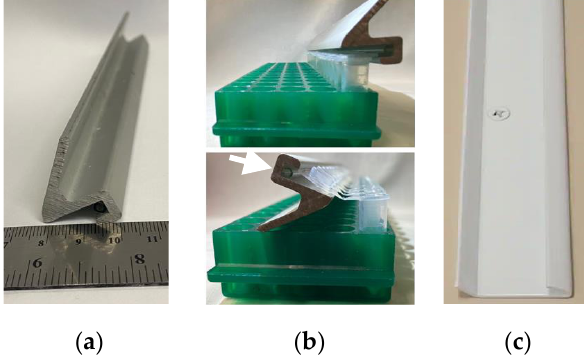
Figure 4. Example of a multi-microtube opener. ( a ) The narrow U-shape accommodates the lid of microtubes, and the metal is sturdy enough to serve as a lever. ( b ) At top, a row of closed microtubes is positioned for opening. At bottom, tubes are opened by twisting the metal in a circular motion over the top of the tubes. The white arrow highlights the 1 mL plastic pipette that was glued into this metal shape to make a narrower groove and better accommodate the microtube lids. ( c ) A product, used for shelving and hanging, that can be purchased inexpensively for this purpose.